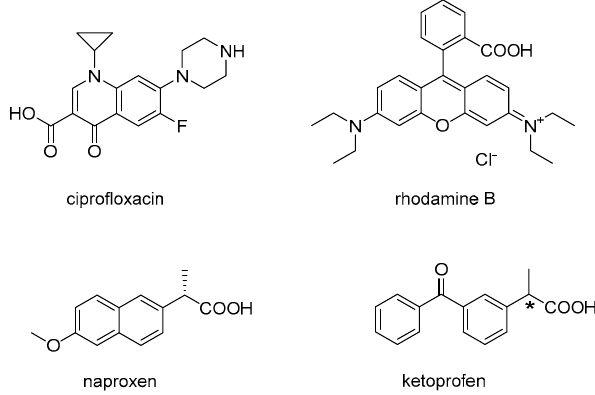
Figure 1. Chemical structures of drug model compounds evaluated for co-assembly with the peptide D Leu-Phe-Phe in previous studies ( top ) and this study ( bottom ). * denotes the chiral centre of the racemic mixture that composes ketoprofen.